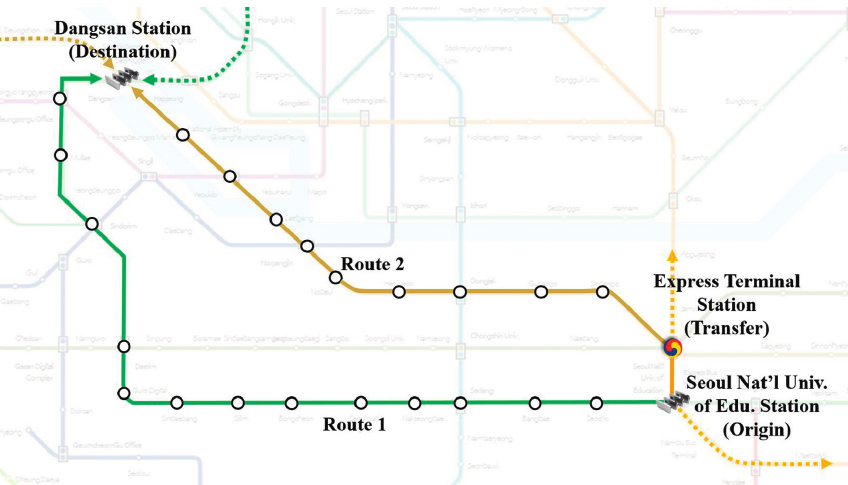
Figure 3: Illustration network with alternative routes from SNUE Station to Dangsan